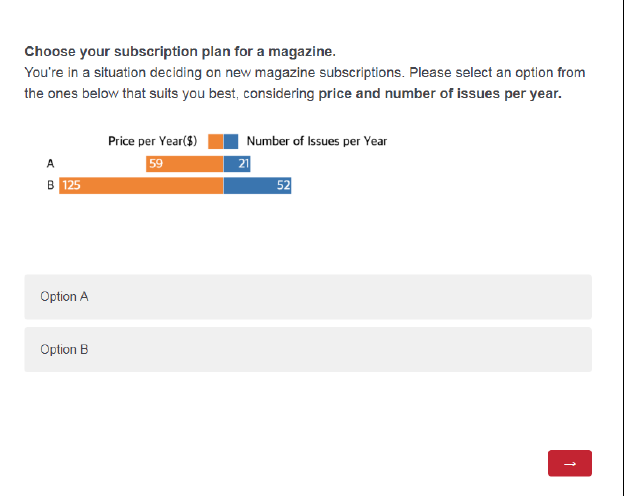
Figure 5. Capture of experimental website with a two-sided bar chart with two options without